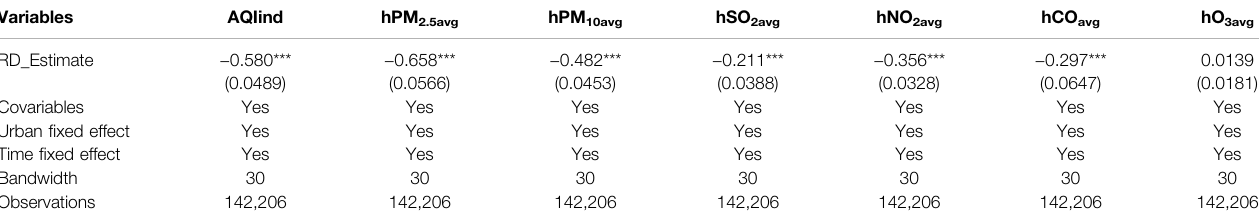
TABLE 4 | Results of the sharp RD design with control covariates.